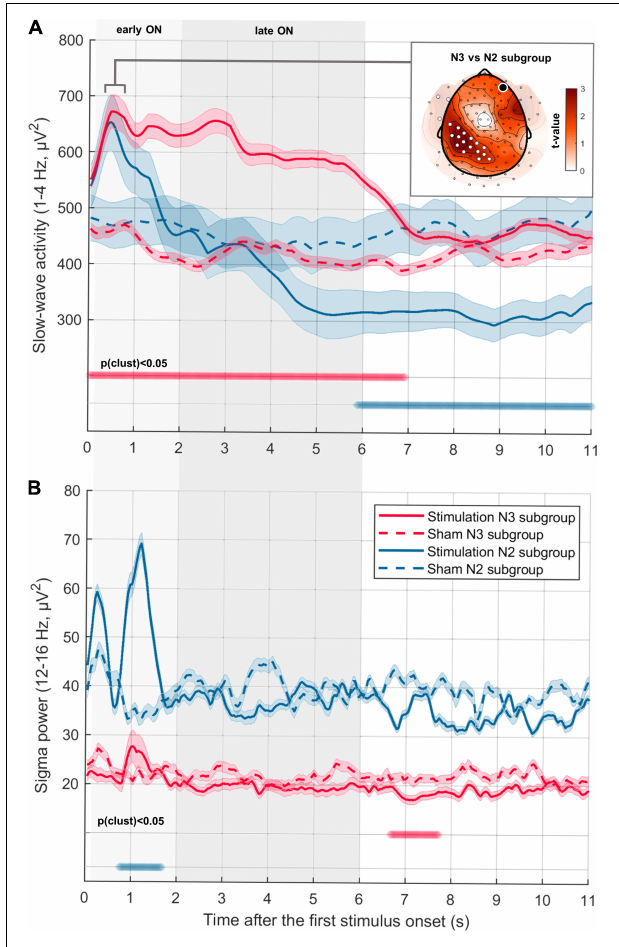
FIGURE 3 | Temporal dynamics of SWA and sigma power depending on sleep depth. (A) Time-resolved dynamics of SWA (1–4 Hz) in consecutive ON-OFF windows for participants with a high percentage of N3 (red line, “N3 subgroup,” N = 7) and participants with a high percentage of N2 (blue line, “N2 subgroup,” N = 7) during the stimulation period (first 2.5 h from sleep onset). Median ± CI (indicated by shaded area around lines) power averaged across all channels is aligned to the first stimulus in ON-windows (first stimulus onset in the Stimulation condition for N3 subgroup: 0.96 ± 0.14 s; for N2 subgroup: 1.26 ± 0.23 s). Thus, the OFF window starts on average after 5.04 s in the N3 subgroup and 4.74 s in N2 subgroup. First 6 s were divided into earlyON (0.2–2 s) and lateON (2–6 s) to account for the potential presence of a K-complex evoked by the first stimulus. Thick horizontal bars indicate time points of significant difference between conditions (cluster corrected paired two-sided t -test, N3 subgroup: p clust < 0.001, d = 1.31; N2 subgroup: p clust < 0.001, d = –1.18). The inserted figure represents the topography of the difference in SWA change in N2 and N3 subgroups during the first induced negative peak (0.3–0.8 s after the first stimulus onset). The black dot indicates the target channel Fp2, white dots indicate a significant increase (cluster corrected two-sided unpaired t -test, N = 7, p clust = 0.03, d = 1.67). (B) Time-resolved dynamics of sigma activity (12–16 Hz) in consecutive ON-OFF windows (same as A) (cluster corrected paired two-sided t -test, N3 subgroup: p clust = 0.02, d = –1.68; N2 subgroup: p clust = 0.01, d = 2.64).